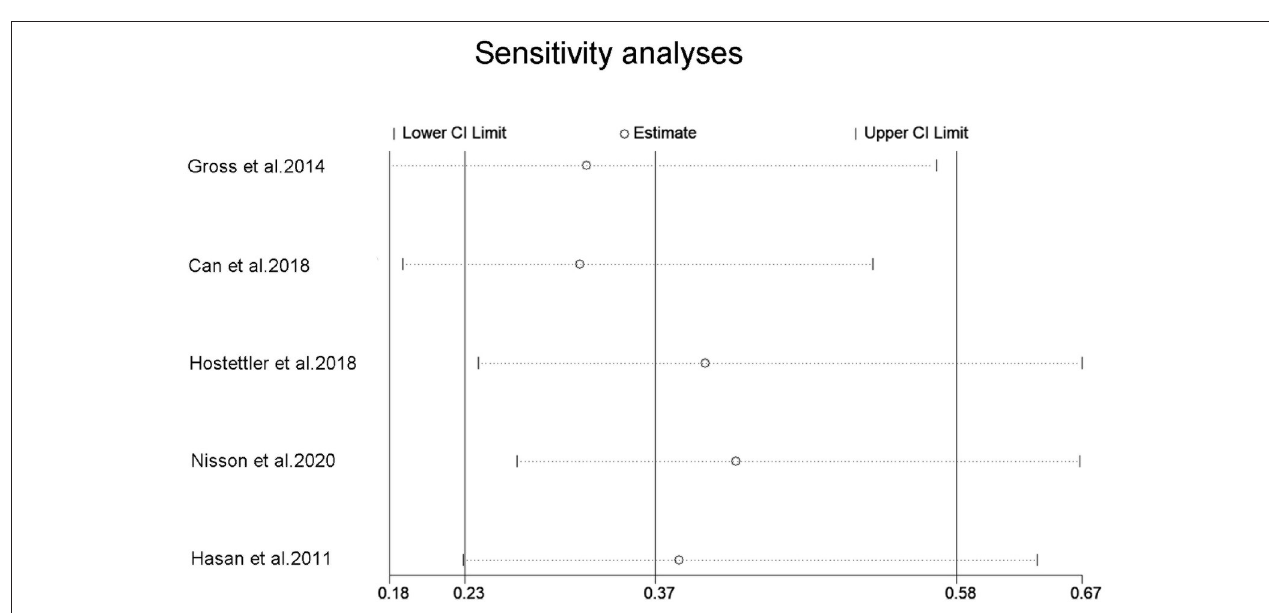
FIGURE 3 | Forest plot for an association between aspirin use and risk of subrachnoid hemorrhage. OR, odds ratio; CI, confidence interval.